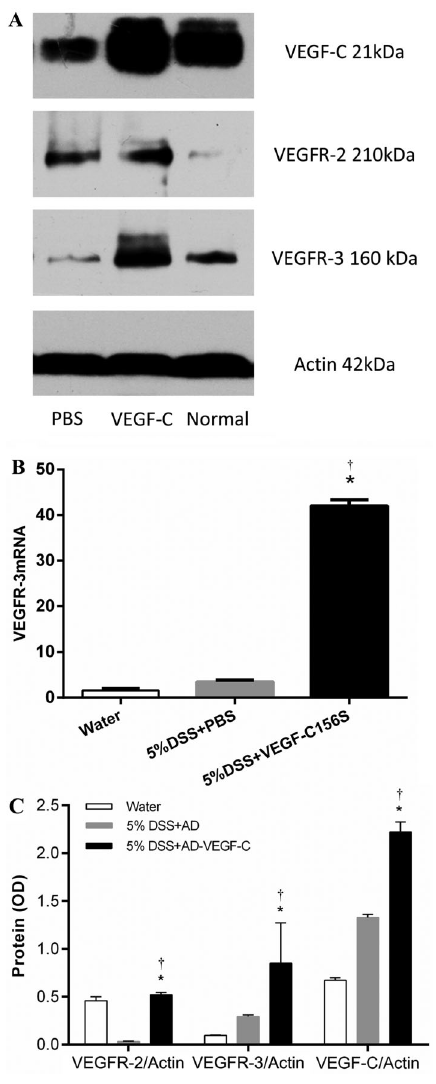
Figure 5. A , Western blot of VEGF-C, VEGFR-2 and VEGFR-3 in the different experimental groups. B , Comparison of VEGFR-3 mRNA expression detected by quantitative real-time RT-PCR. VEGFR-3 mRNA levels were signi fi cantly upregulated in VEGF- C156S-treated mice compared to DSS-treated mice (P o 0.001) as well as water-treated mice (P o 0.001). C , Quantitative comparison of Western blot of VEGFR-2, VEGFR-3 and VEGF-C between experimental groups. VEGF-C expression was upregulated in AD-VEGF-C-treated mice compared to DSS-treated mice (P o 0.001). DSS-treated mice had higher levels of VEGF-C expression compared to water-treated mice (P o 0.001). VEGFR-3 expression in colonic mucosa was higher after VEGF-C treatment compared to mice treated with water (P=0.001) or DSS (P=0.01). Data are reported as means ± SD. *P o 0.05 compared to 5% DSS- treated mice. w P o 0.05 compared to water-treated mice (n=5/group). Statistical analysis was performed by ANOVA and Bonferroni ’ s